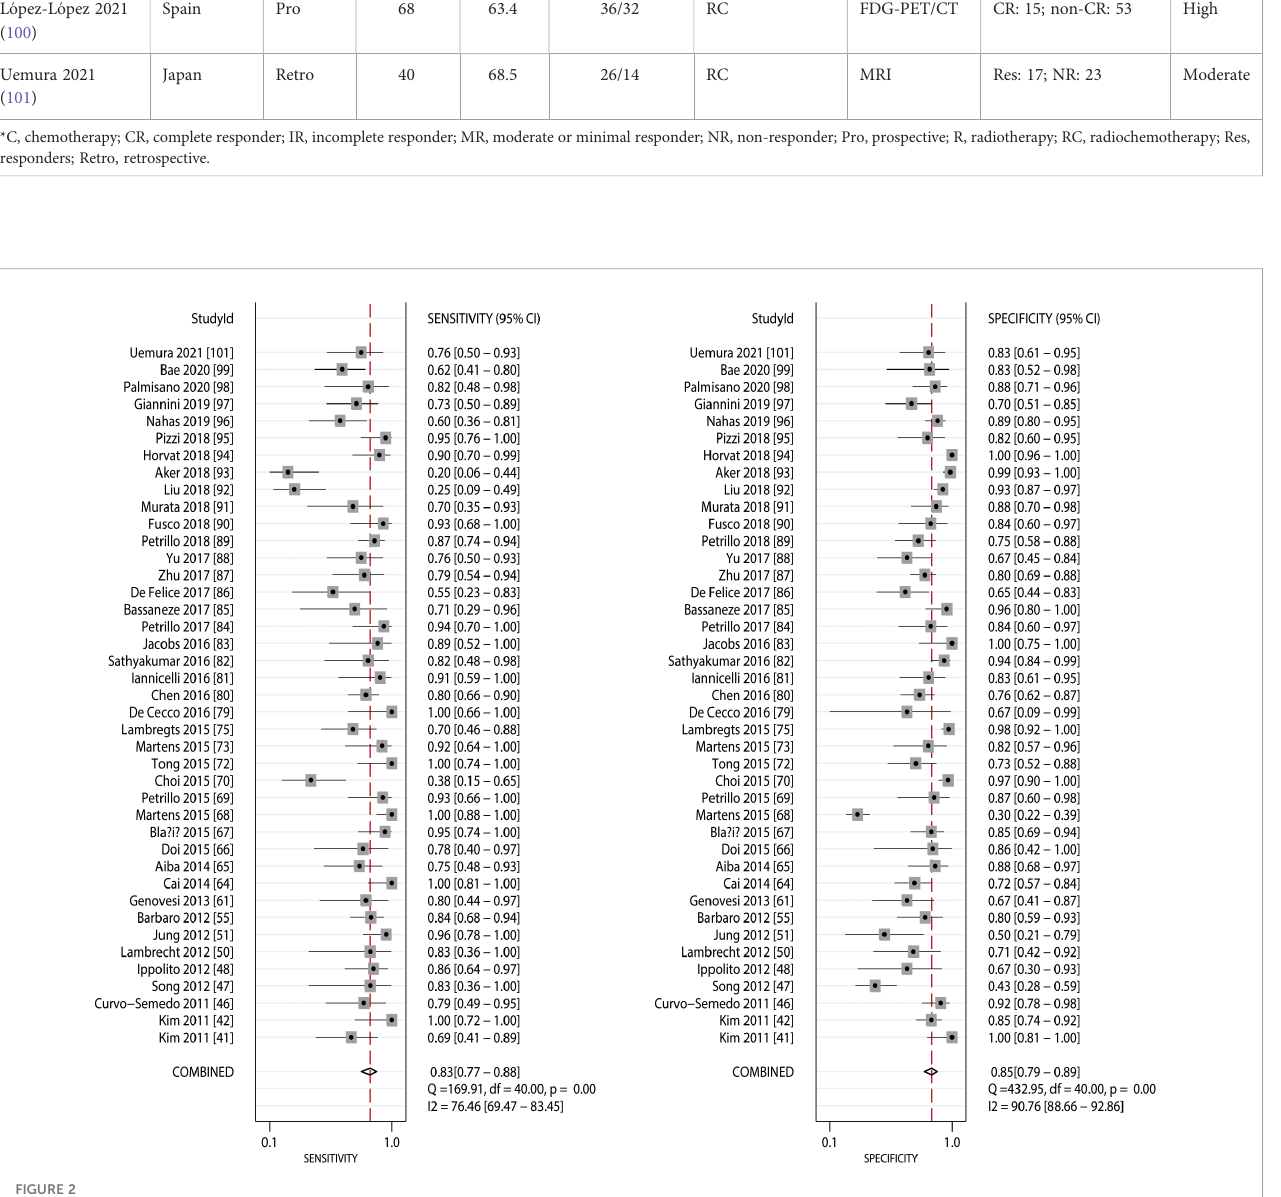
FIGURE 2 Pooled sensitivity and speci fi city of